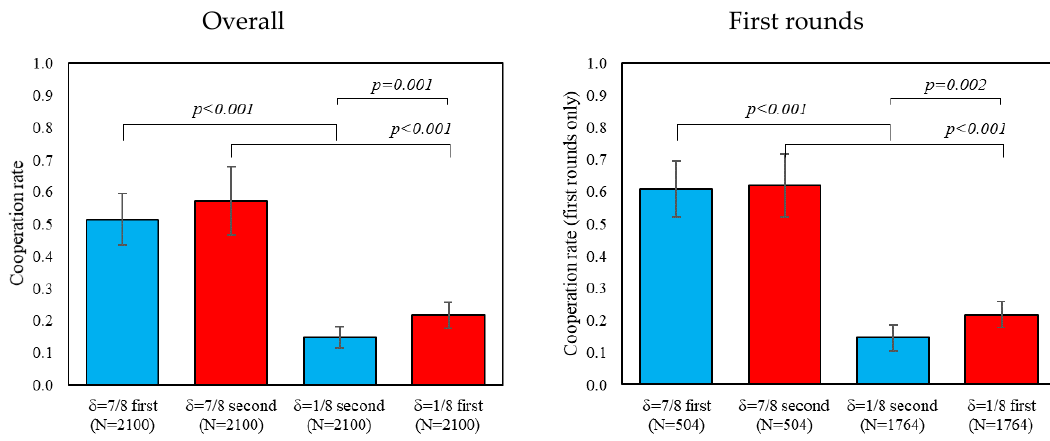
Figure 1. Difference in first rounds and overall cooperation by treatment. In addition, 95% confidence intervals clustered by session.